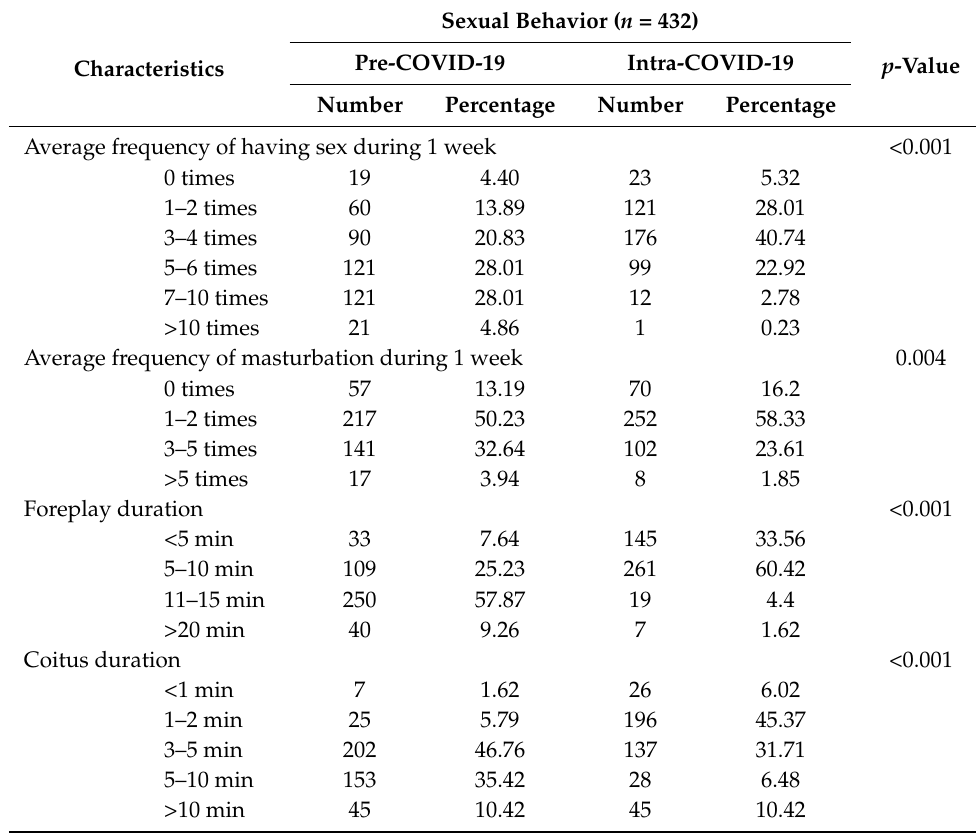
Table 2. Sexual behavior between pre-COVID-19 and intra-COVID-19.